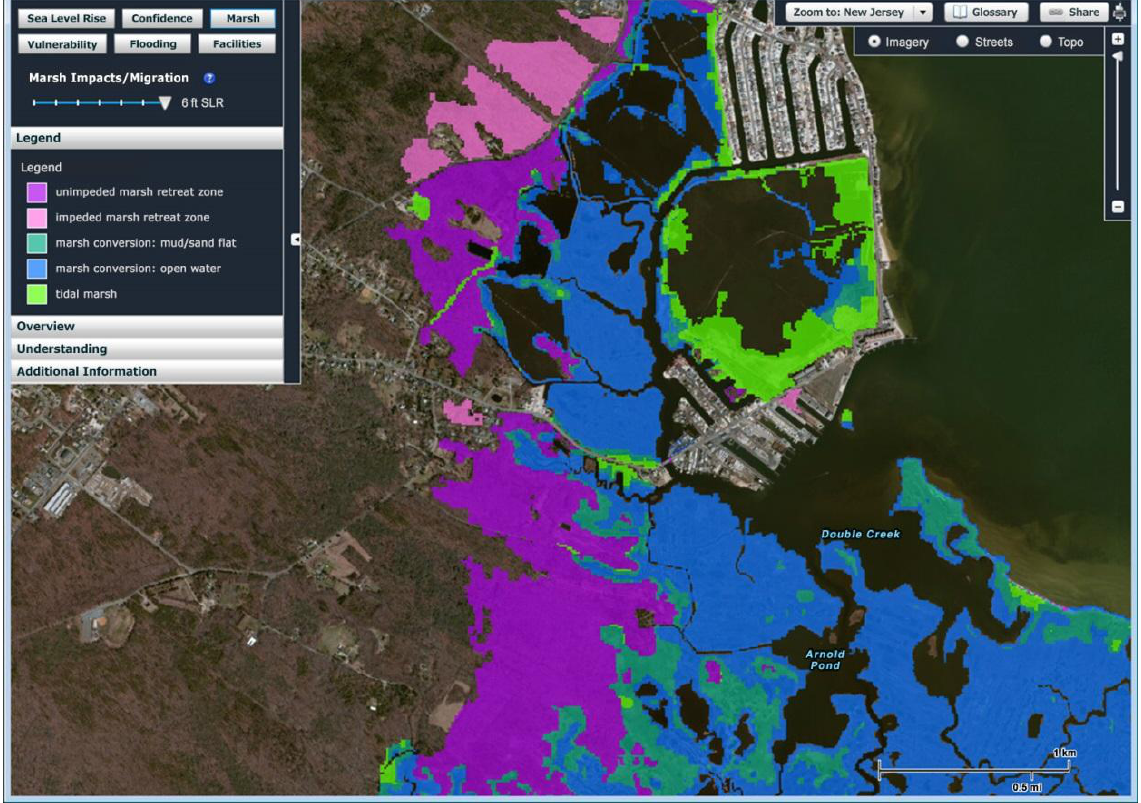
Figure 4. Example of unimpeded vs. impeded horizontal tidal marsh retreat zones in the NJFloodMapper viewer under six feet of projected sea level